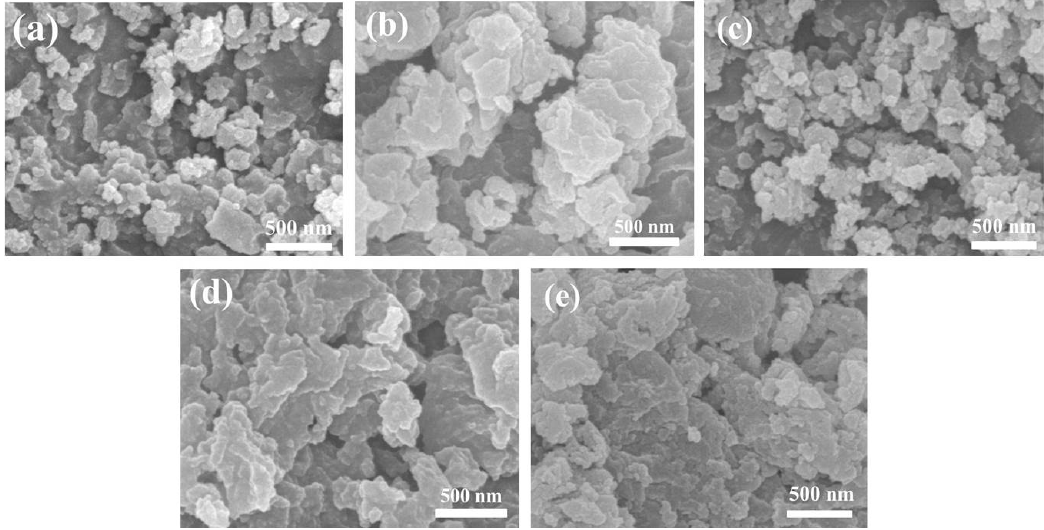
Figure 1. The FESEM images of Zr–Mg mixed oxide aerogels with Zr/Mg molar ratio of ( a ) 10/0, ( b ) 9/1, ( c ) 8/2, ( d ) 7/3, and ( e ) 6/4.